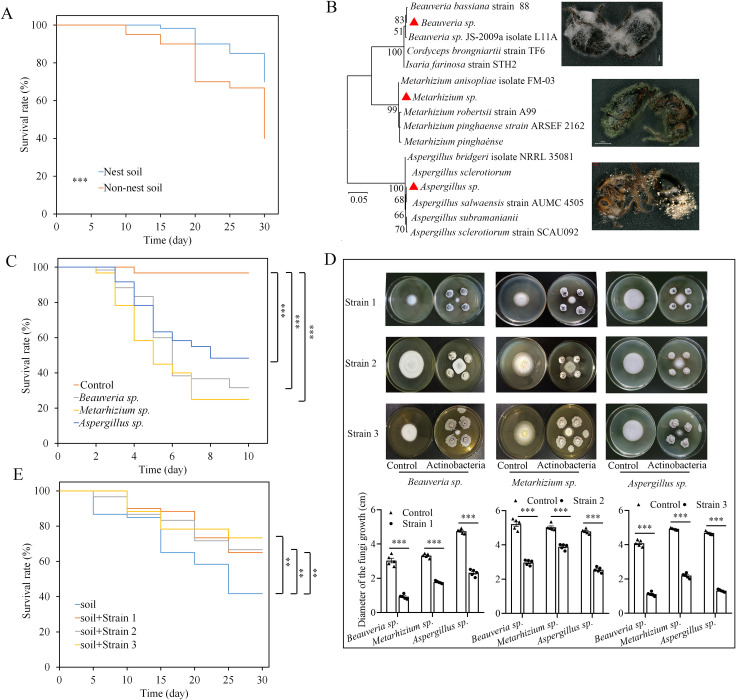
Entomopathogenic fungi from soil not favored by S. invicta decreases the survival of ant queens.(A) Kaplan-Meier plot of queen survival after they were forced to build nests in soil from nesting and non-nesting sites (log-rank test). (B) Molecular phylogenetic analysis of fungal strains isolated from soil from non-favored nesting areas based on ITS gene sequences. Tree was constructed with a maximum likelihood estimation method. Branch support is indicated as bootstrap values (500 replicates). Red triangles indicate the isolated fungi. (C) Kaplan-Meier plot of S. invicta queen survival after infection with the isolated fungi (log-rank test). (D) Inhibition effects of the isolated actinobacteria (Fig 3) on the entomopathogenic fungi. On each plate, the fungi were placed in the middle, and the actinobacteria were placed on the four corners of the fungal plug. (E) Kaplan-Meier plot of queen survival after adding the isolated strains of actinobacteria to soil from non-favored nesting sites (log-rank test). Asterisks indicate significant differences (*P < 0.05, **P < 0.01, ***P < 0.001).